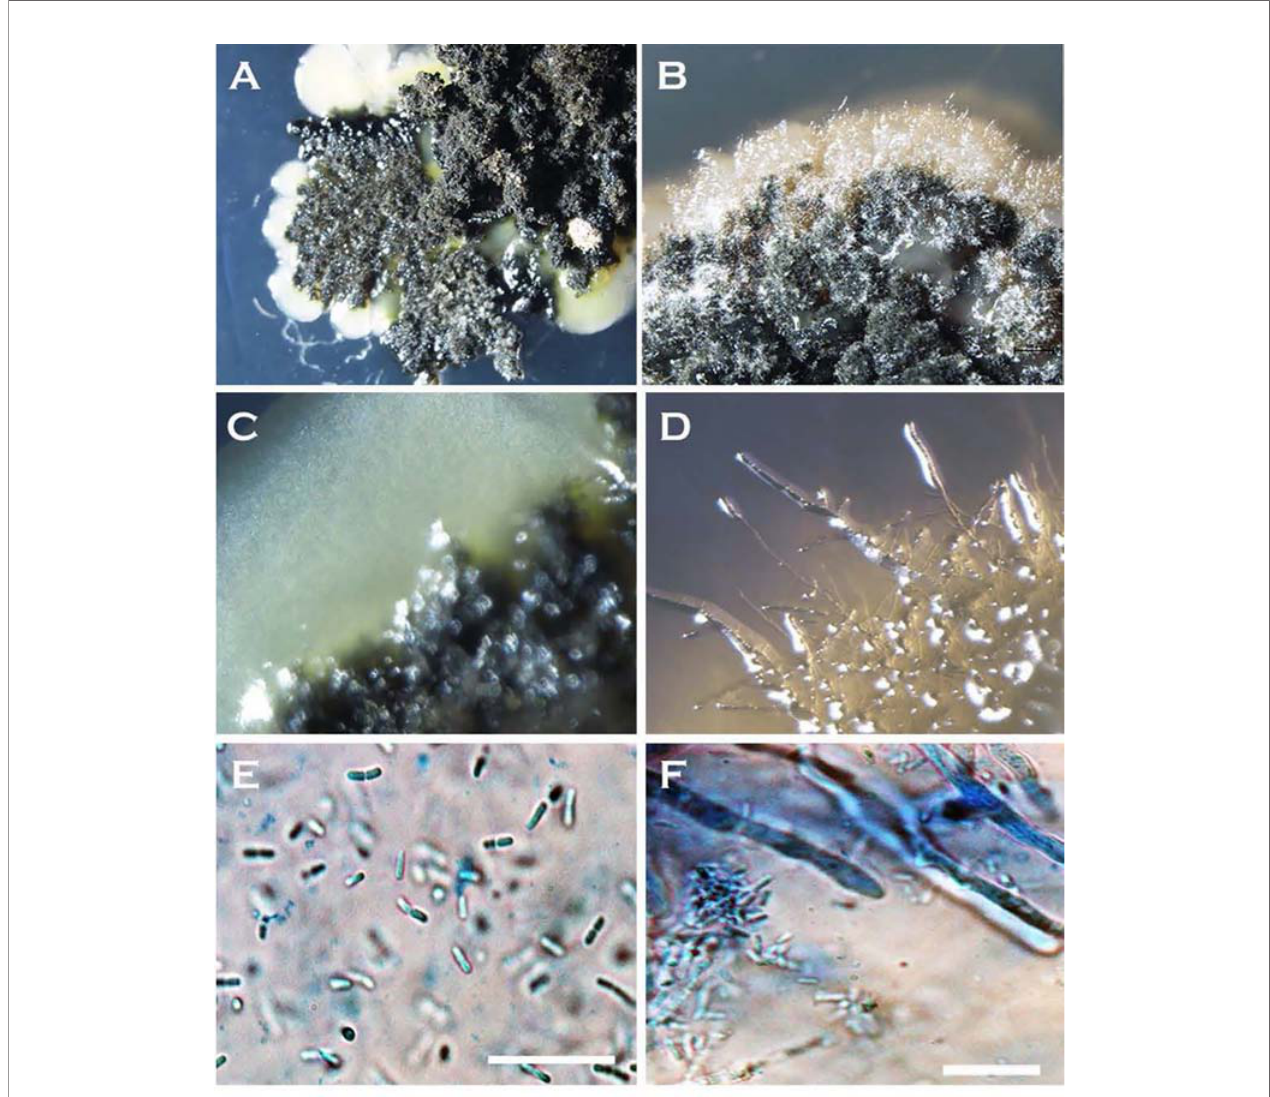
FIGURE 3 | Morphological transformation (hyphae-to-yeast) of Neopseudocercosporella capsellae cultures on growth media where blastospores are seen as creamy white to tan masses at the edges of colonies (A – D) . Colonies at the time of hyphae to yeast transformation, (A) seven week old colony of isolate UWA Wlj-3 on NDY, and (B) fi ve week old colony of isolate UWA Wlra-7 on PDA. (C) Edge of the UWA Wlj-3 colony, and (D) edge of UWA Wlra-7 colony, where hyphae-to- yeast transformation occurred. (E) Blastospores from UWA Wlj-3 colony and (F) hyphae from UWA Wlra-7 colony, both stained with 1% cotton blue in lactophenol and as seen under the light microscope. Scale bar =